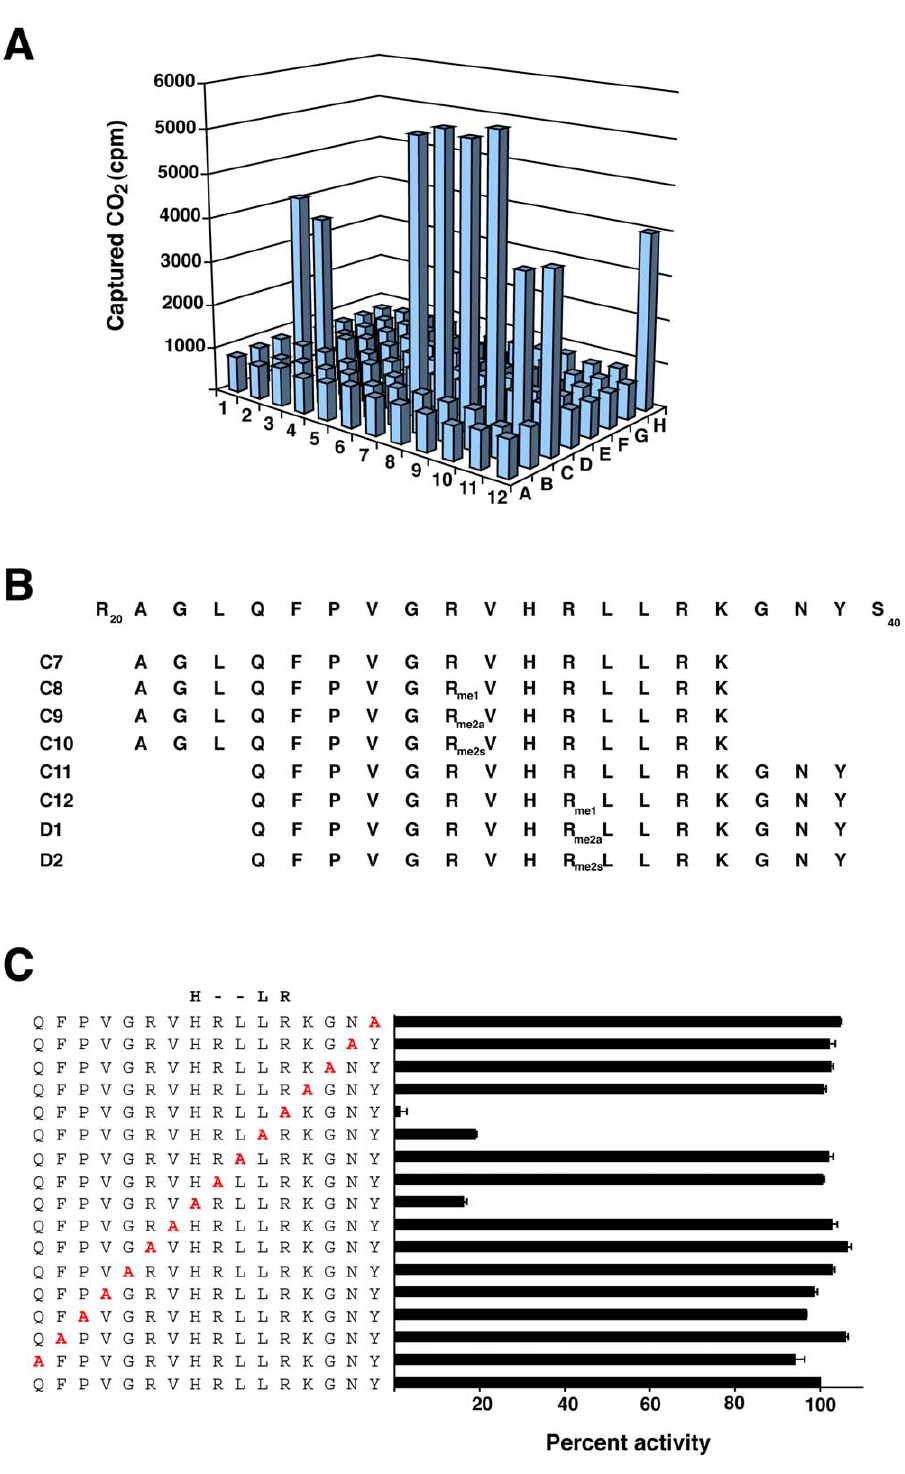
Figure 2. Identification of a motif in H2A required for Ofd2 dioxygenase activity. A) Dioxygenase assay of Ofd2 with H2A peptide library. Activity was evaluated with the CO 2 capture assay using 1ug of purified Ofd2 with 6ug of peptide or 25ug of BSA (H11) and cBH (H12). For a list of peptide sequences see Table S7. B) Alignment of peptide amino acid sequence of 8 postive peptides (C7-12, D1-2) from A with histone H2A sequence. C) A HxxLR substrate motif for Ofd2. Alanine scanning analysis of peptide sequence C11 was evaluated with the CO 2 capture assay using 1ug of Ofd2 with 6ug of peptide. Alanine substitutions are indicated in bold red. Data is from 2 replicates presented as a percent activity of captured CO 2 relative to unmodified C11 peptide. Error bars equal 1 standard deviation. Residues found to be essential for activity are highlighted above peptide sequence.